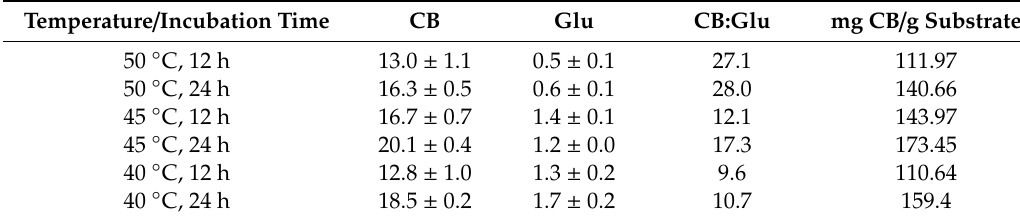
Table 2. Trials with di ff erent temperature and incubation time. All experiments have been conducted upon the addition of 1.98 mM conduritol-B-epoxide and a pH 7.0, while bu ff er exchange was applied at 12